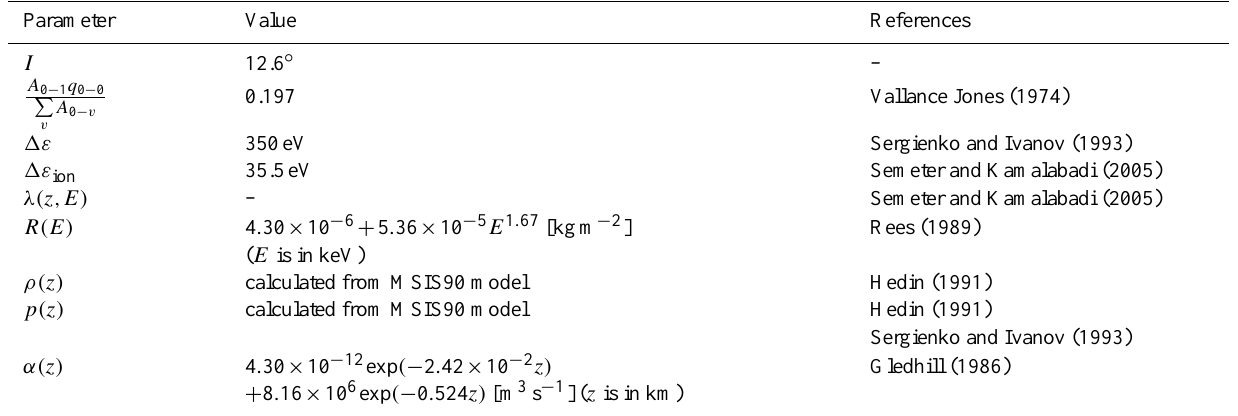
Table A1. Simulation